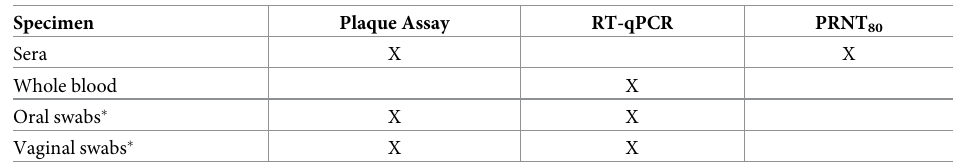
Table 3. Specimens and associated Zika virus assays.